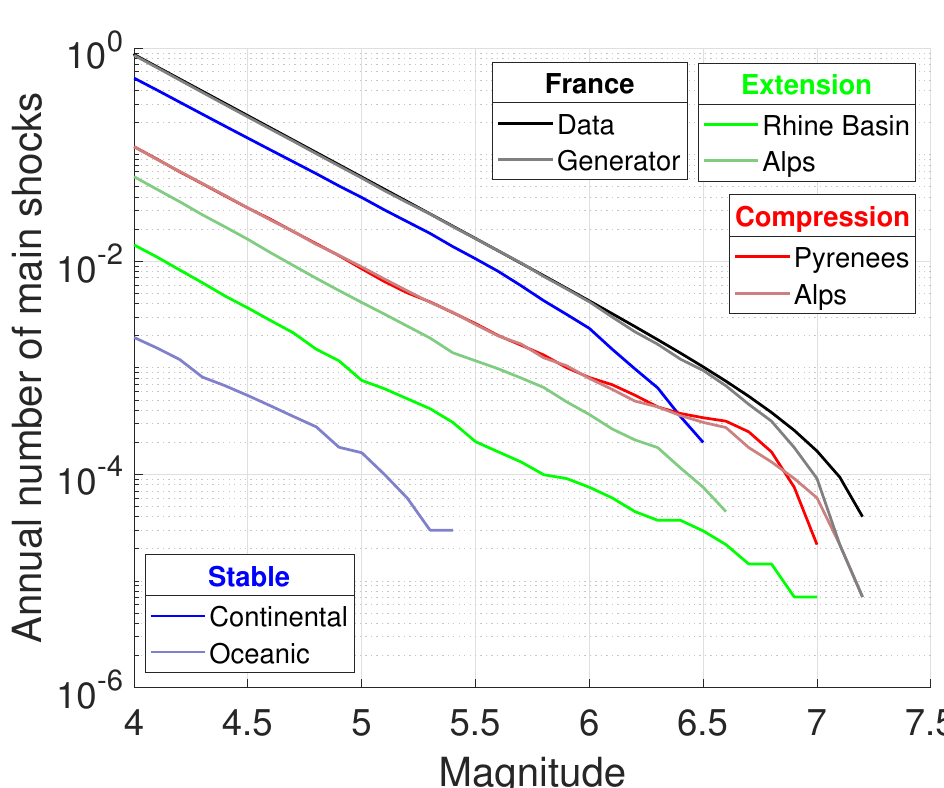
Figure 10. Mean frequency–magnitude distributions of main shocks given as input (black) and observed in a synthetic catalogue of 100,000 years for the whole of mainland France (grey) and for the SHARE regions (Figure 4).